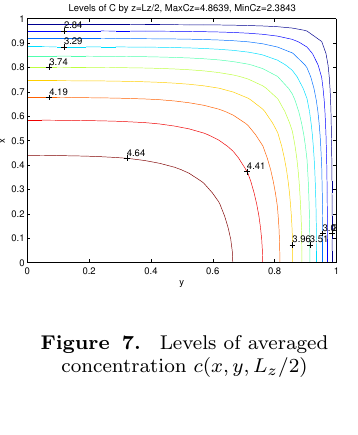
Figure 7. Levels of averaged concentration c ( x,y,L z / 2)